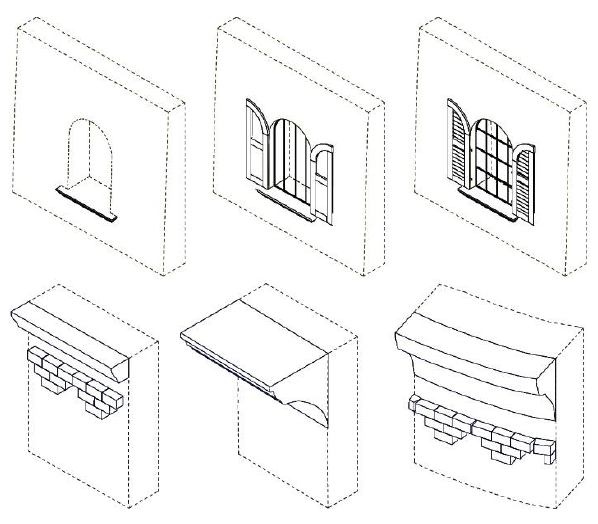
Figure 4 . From the top: parametric family for a window, parametric family for wall decorative